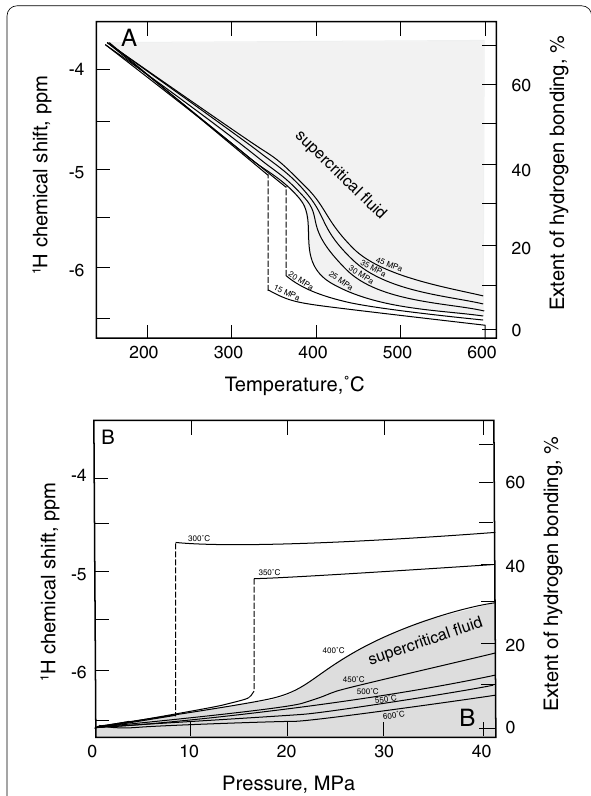
Fig. 28 1 H NMR chemical shift of O A . as a function of temperature, and. B . As a function of pressure. Translation to extent of hydrogen bonding is based on relationship between chemical shift and H 2 O fluid density. Modified from Hoffman and Conradi